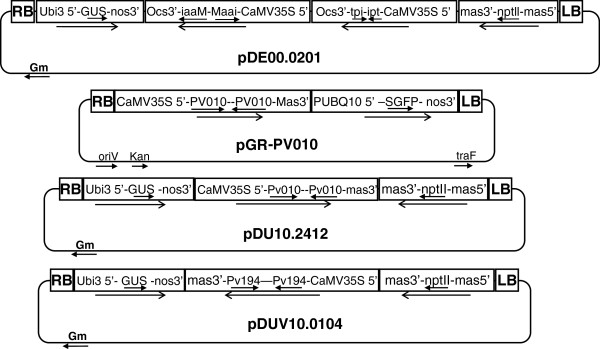
Binary vectors used for walnut transformation. The Agrobacterium binary vectors pDE00.0201, for expression of self-complementary iaaM and ipt oncogenes, and pDU10.2412 and pDUV10.0104, for Pv010 and Pv194 gene silencing, are shown. The pGR-Pv010 vector was used for co-transformation of walnuts with vector pDE00.0201. Arrows indicate the direction of transcription. LB and RB indicate the left and right T-DNA border sequences.